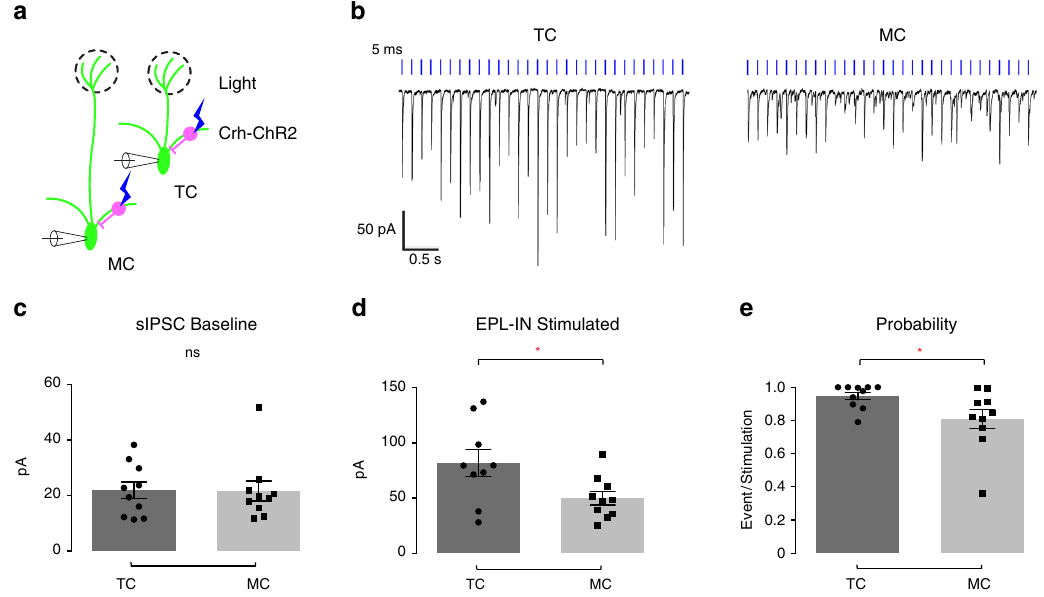
Fig. 3 EPL-INs provide stronger inhibition onto TCs than MCs. a Illustration depicting targeted voltage clamp recordings of TCs/MCs during optogenetic stimulation of EPL-INs. b Representative traces of TCs and MCs during photostimulation. c Baseline sIPSC frequencies of TCs and MCs, Two-tailed t -test. d Light-evoked IPSC amplitude between TCs and MCs, * p < 0.05, Two-tailed t -test. e Probability of evoked IPSC between TCs/MCs per stimulation. * p < 0.05, Two-tailed t -test. n = 10 cells/4 animals per group. Average across 30 s ±